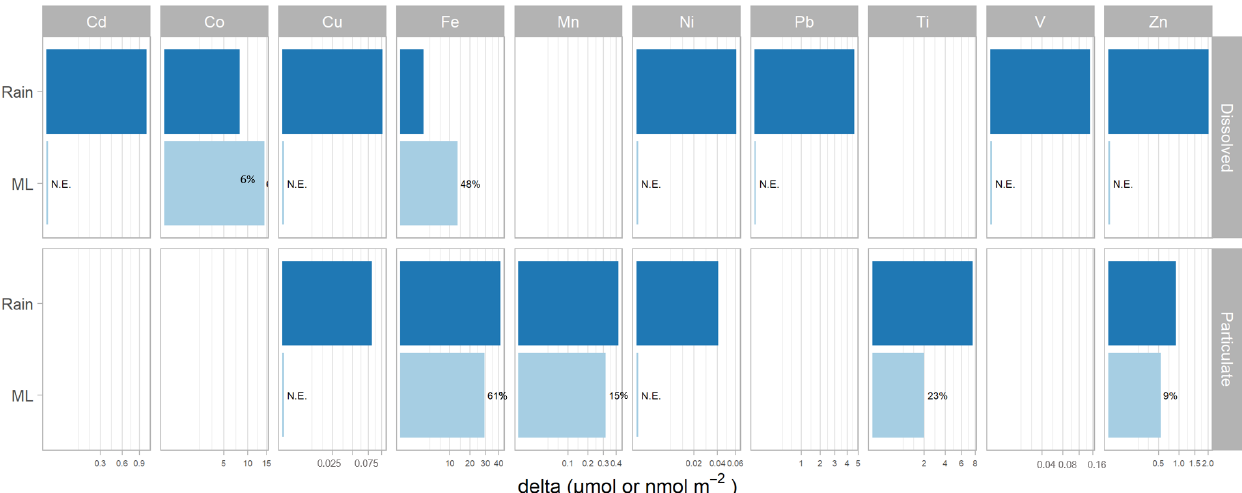
Figure 9. Comparison between TM wet deposition fluxes (dark blue) and TM marine stock deltas (before and after the rain) in the ML (light blue) at FAST. Dissolved stocks are given in the upper panels, and particulate stocks are given in the lower panels. Marine stock increases are expressed as absolute values (Cd, Co and Pb stocks and fluxes are given in nmolm − 2 , and the other TMs are given in µmolm − 2 ) and in relative values (%). N.E. stands for not enhanced (increase <